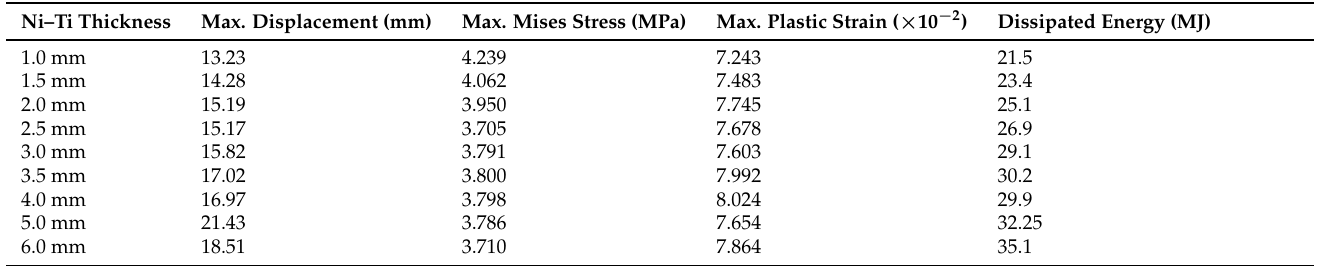
Table 7. Comparison between the mechanical parameters of the walls reinforced with different Ni–Ti